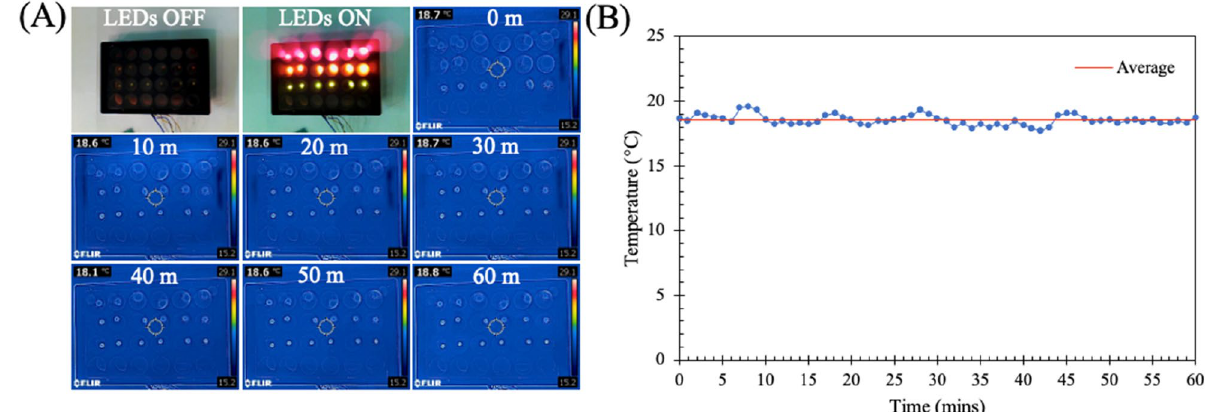
Figure 2. Characterisation of temperature change from LEDs using a thermal camera. Images taken every minute for 60 min. ( A ) Thermal images of LED array in 24-well plate from time 0 min to 60 min. ( B ) Graph showing temperature variation as measured by the thermal